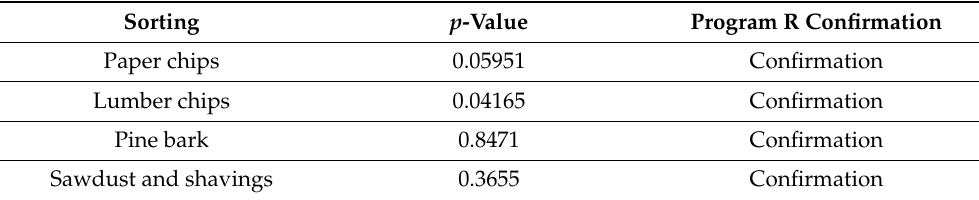
Table 10. Diebold–Mariano test results of the prediction efficiency of ARIMA and WH. Sorting p